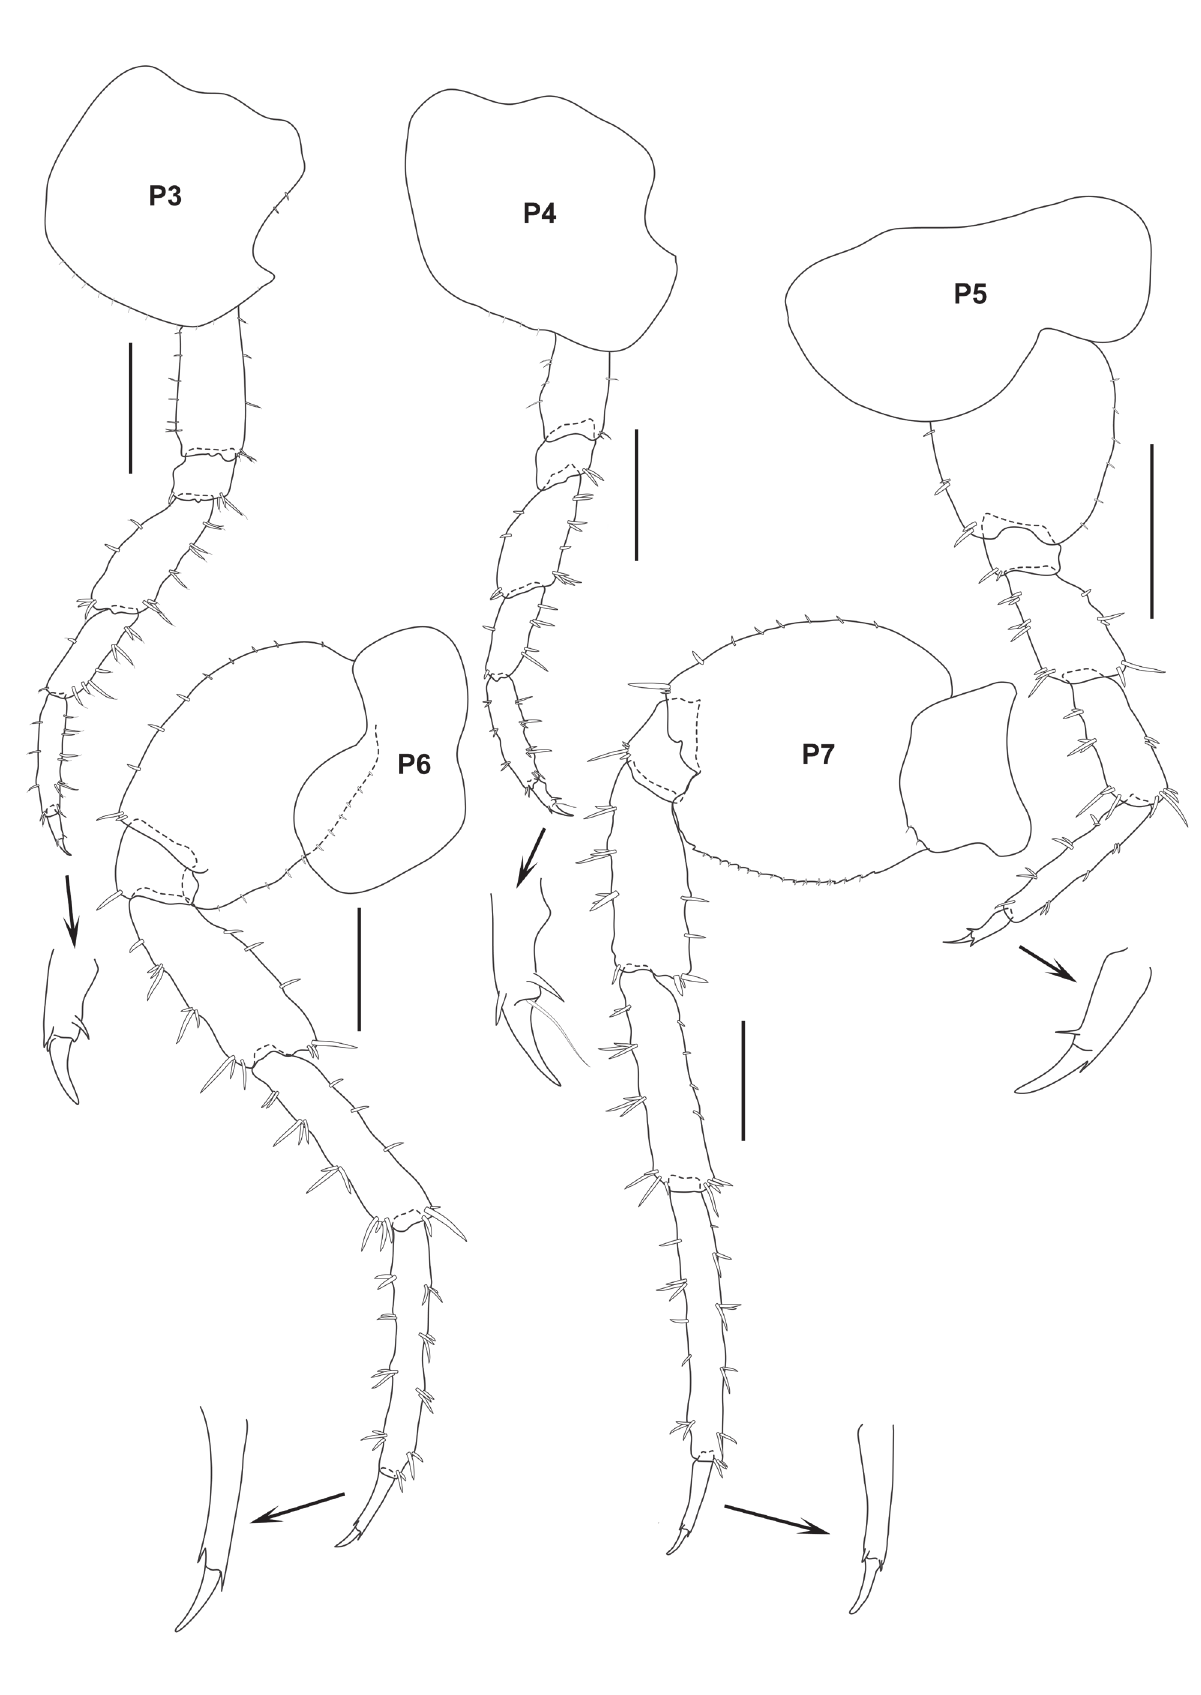
Figure 4. Floresorchestia samroiyodensis sp. n., holotype, female, (PSUZC-CR-0275) 10.6 mm. Khao Sam Roi Yod National Park. All scales represent 0.5